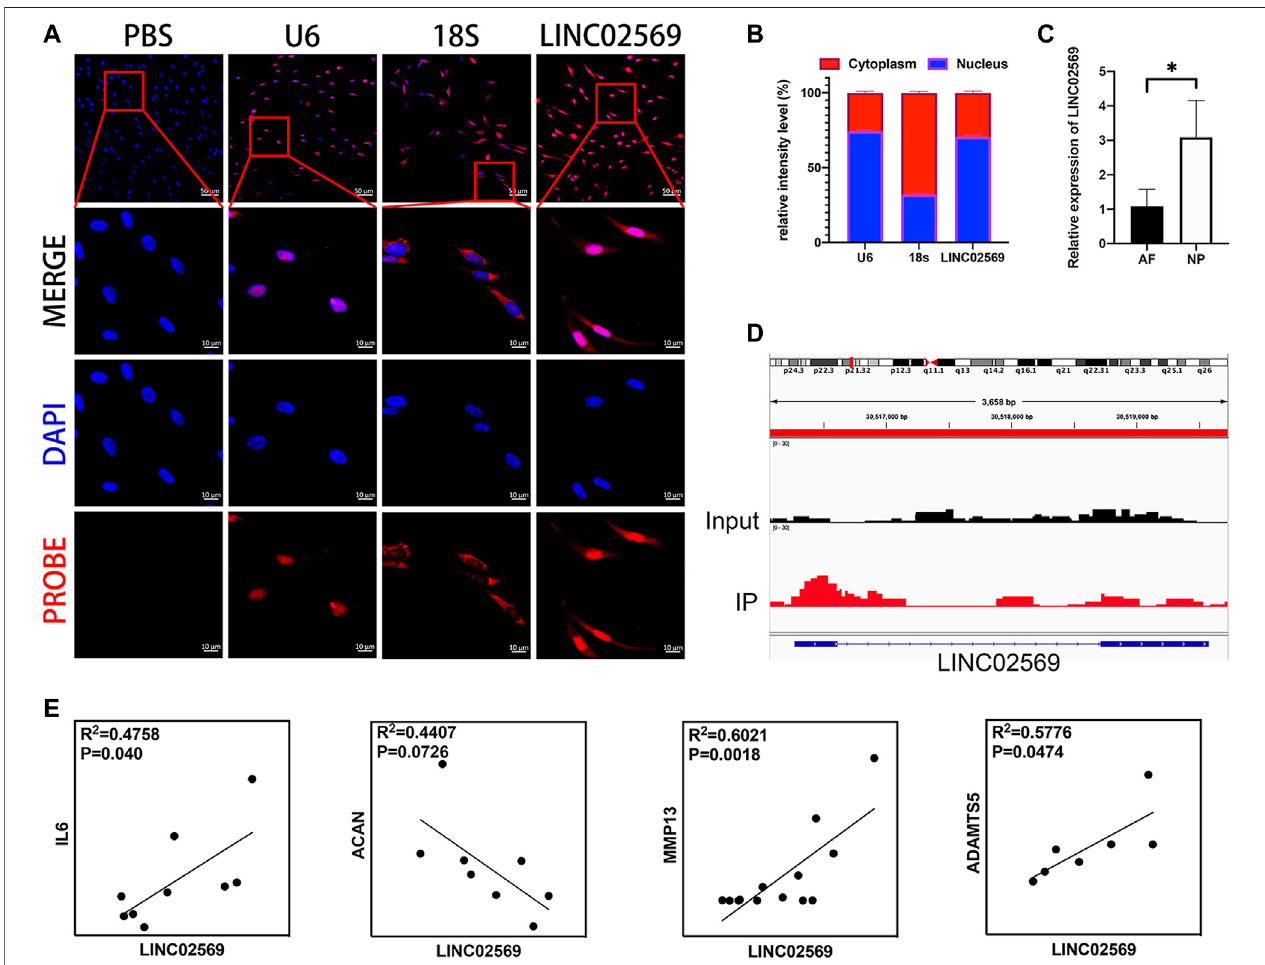
FIGURE 2 | LINC02569 is eRNA and relevant to the progression of NP degeneration. (A) NPCs were stained with LINC02569 probe (red) and nuclear marker (DAPI, blue), while U6 and 18S was used as nucleus marker and cytoplasm marker respectively. Scale bar: 10 μ m (B) Percentage of nucleus (blue bar) and cytoplasmic (red bar) average fl uorescence intensity of U6, 18S and LINC02569 measured by ImageJ 1.0 after FISH. (C) qRT-PCR assay of LINC02569 expression in NP or AF. (D) ChIP-seq assay of H3K27ac signature of the locus encompassing LINC02569 in NPCs. (E) Scatter plot of qPCR assay showed correlation of expression between LINC02569 and IL6, ACAN, MMP13 and ADAMTS5. R2 and p values were determined by Pearson ’ s correlation test. Quantitative results are shown as the mean ± SD. p p < 0.05.